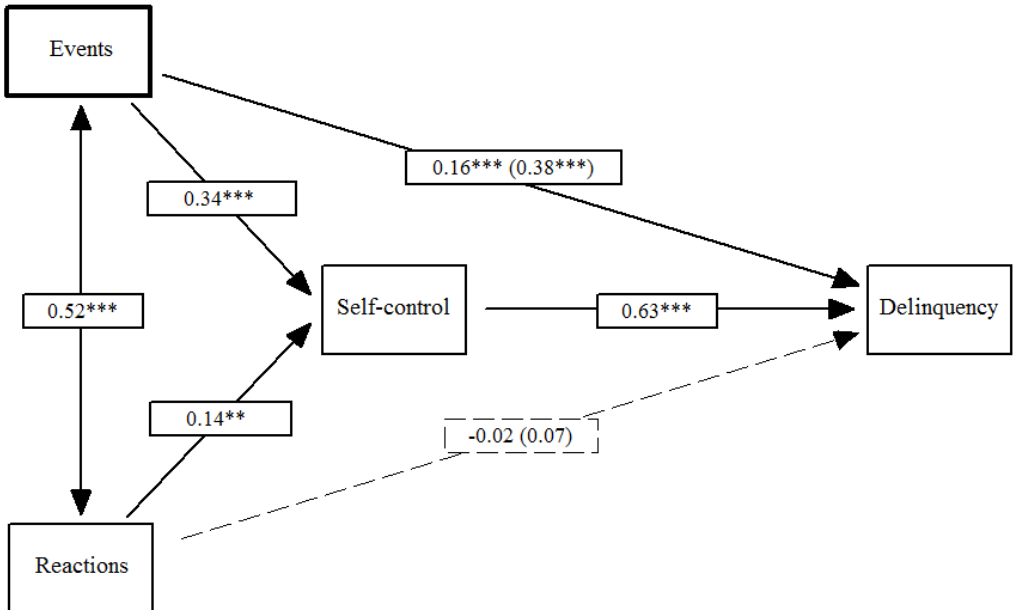
Figure 1. Effects of traumatic events and reactions on self-reported delinquency mediated by low self-control. Note: Total effects are included in parentheses; ** p ≤ 0.01, *** p ≤ 0.001.